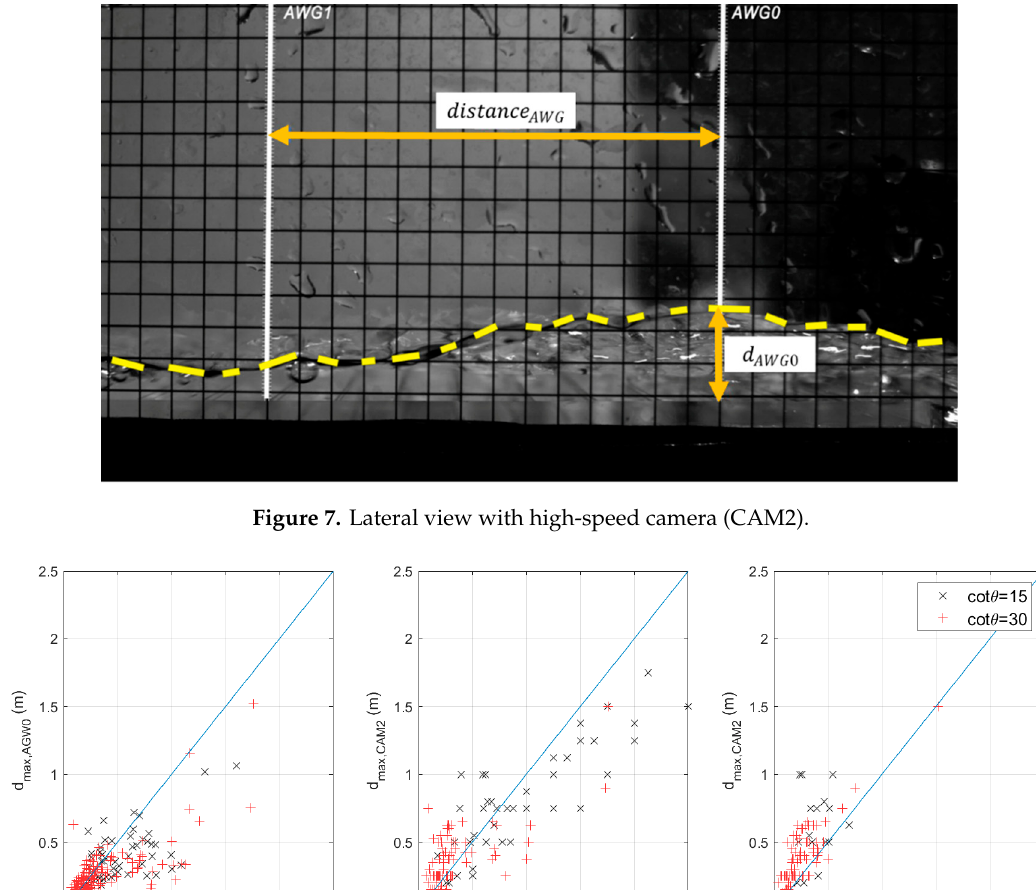
Figure 8. Correlation between overtopping flow depths measured with ultrasonic sensors and high-speed cameras.